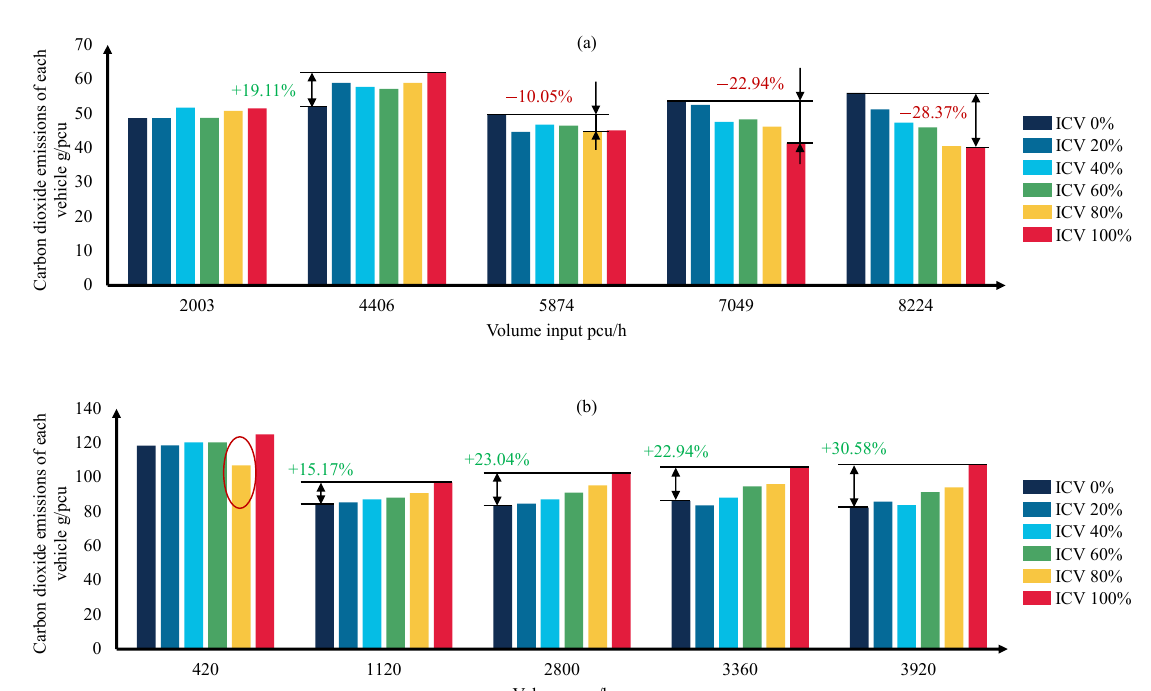
Figure 3. The impacts of SLADS on the average CO 2 emissions per vehicle on the expressway ( a ) and the secondary motorway ( b ).